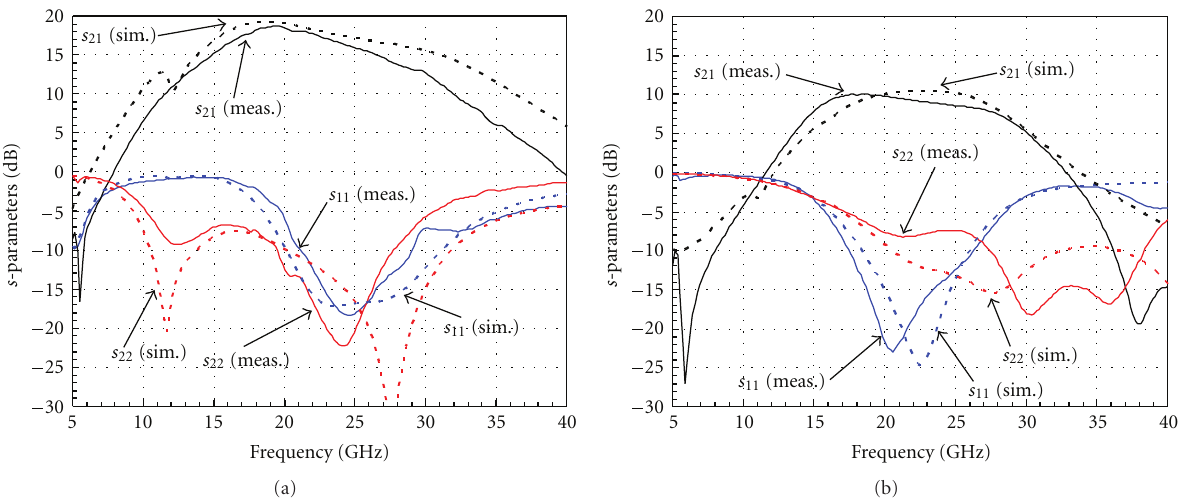
Figure 5: Measured and simulated s -parameters of the dual-LNA MMIC with subcircuits LNA1 (a) and LNA2 (b) designed for low NF and high linearity, respectively.